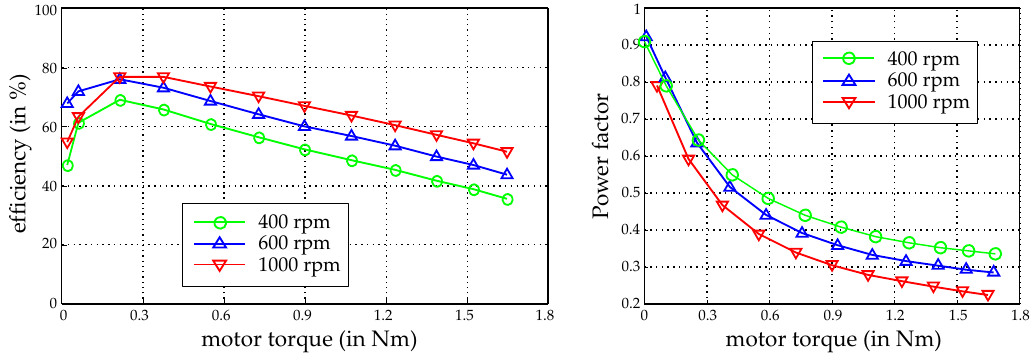
Figure 15. Efficiency and load factor of the manufactured bearingless flux-switching